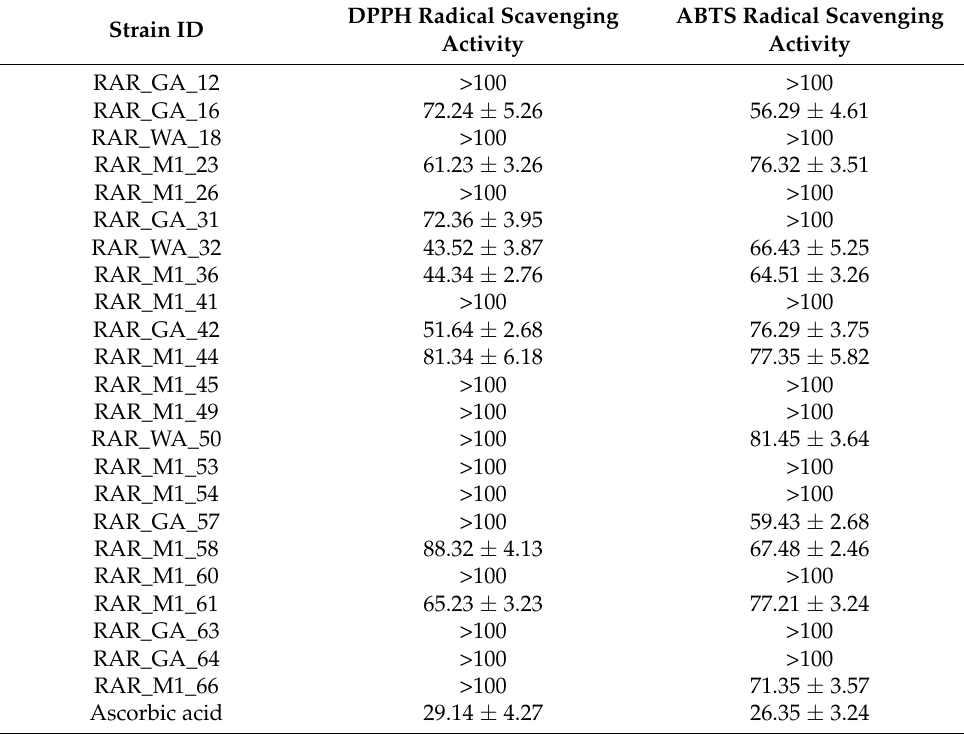
Table 3. DPPH and ABTS radical scavenging activity of the bacterial extracts (IC 50 , µ